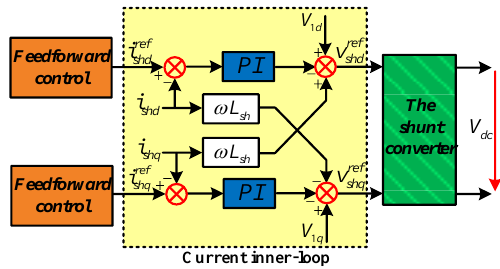
Figure 10. The basic control scheme of the shunt converter.